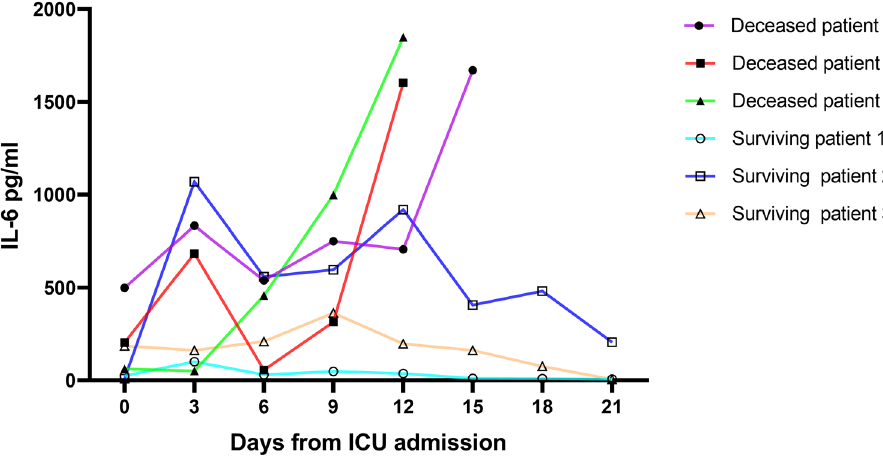
Figure 3. The variation trend of IL-6 levels in six patients (3 in deceased group and 3 in surviving group) during hospitalization. Abbreviations: IL-6: